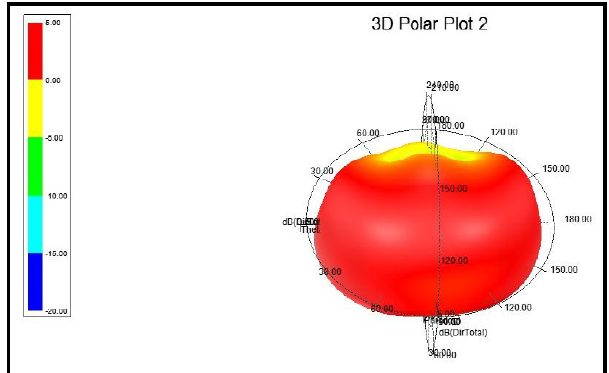
Figure 9: Polar radiation pattern of antenna at 2GHz.